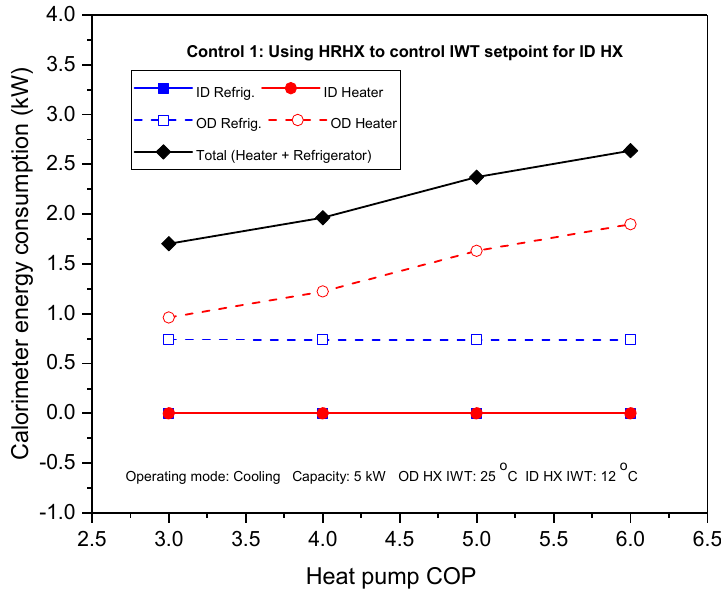
Figure 16. Calorimeter energy consumption with cooling COP variation in control (1).